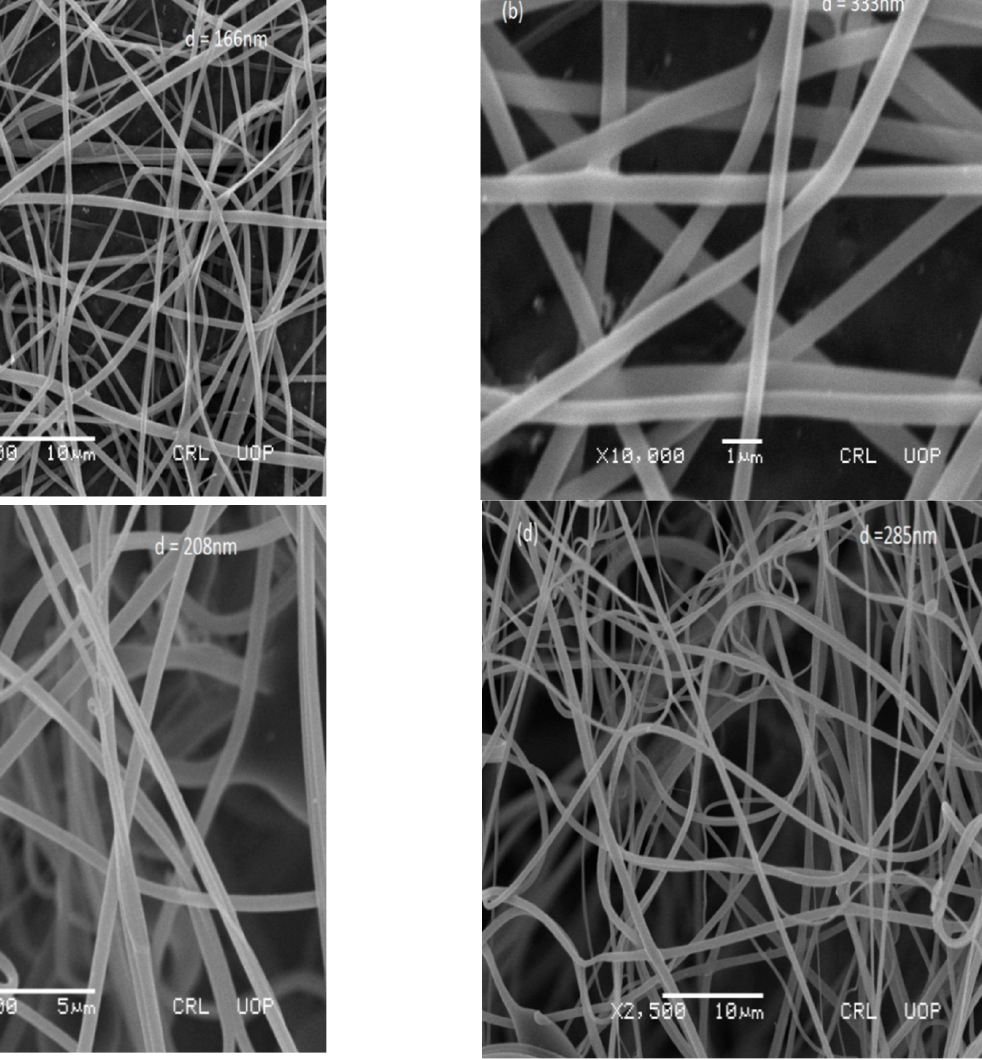
Figure 3. ( a – d ): SEM images with diameters in nanometers.